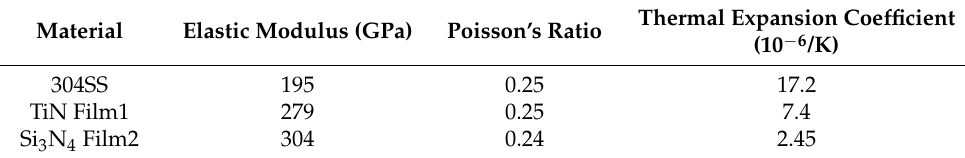
Table 1. Material properties of TiN film, Si 3 N 4 film, and 304SS substrate.